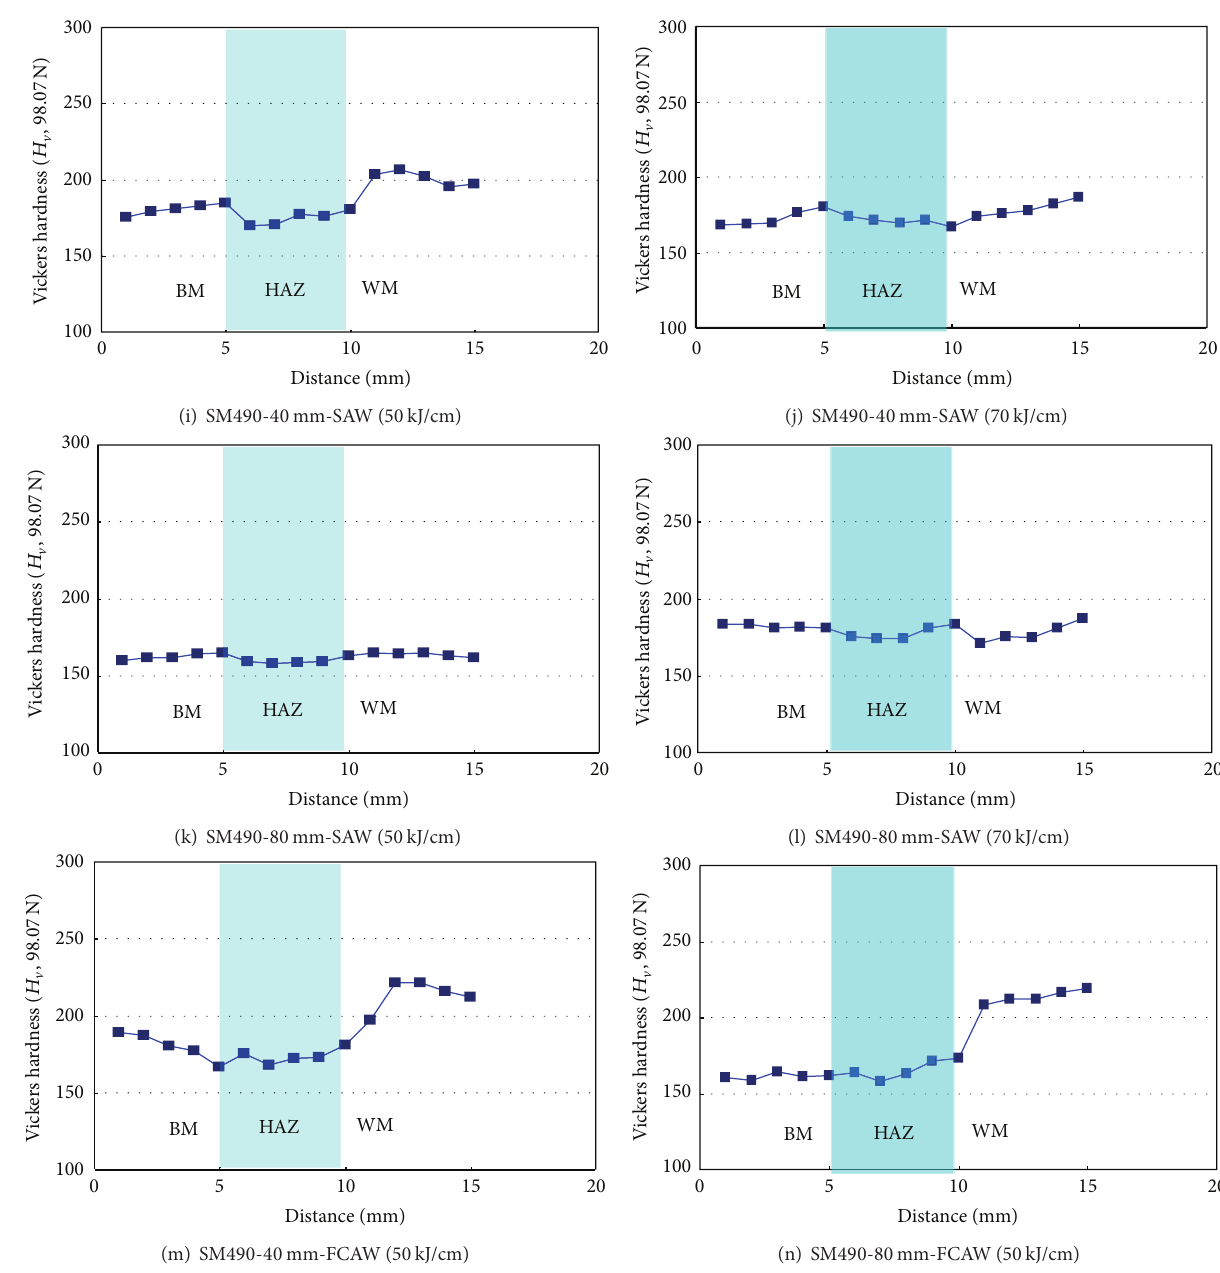
Figure 11: Hardness test results of SAW, FCAW, and ESW welding for SM490TMCP and